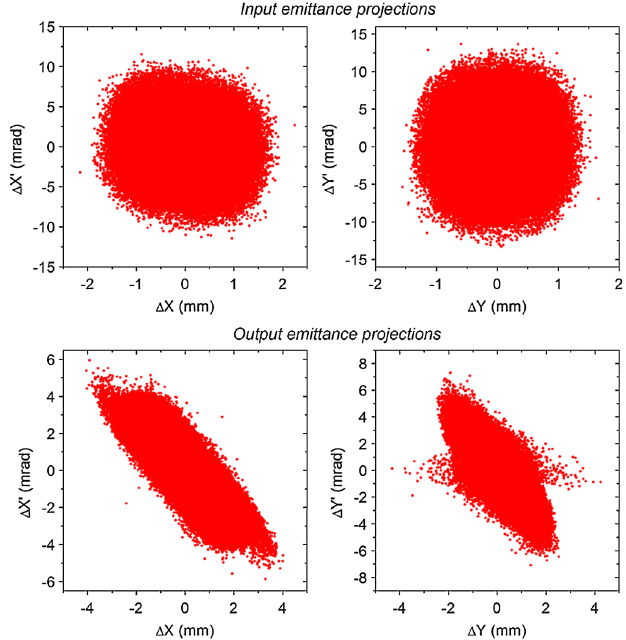
FIG. 18. (Color) Transverse emittance projections at the input and output of the EUROTRANS DTL part for 5